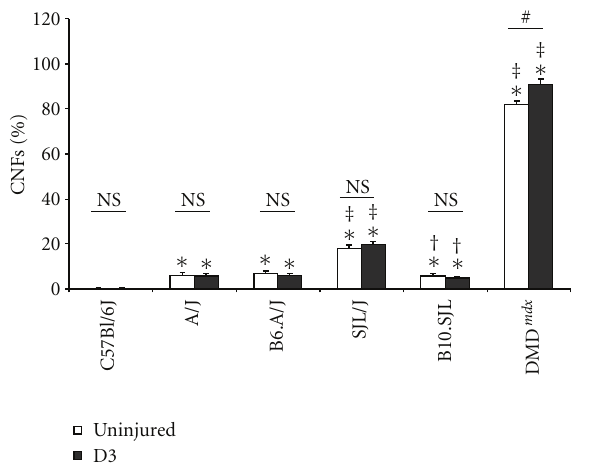
Figure 6: Quantitation of necrotic fibers. We counted necrotic fibers in H&E-stained cross sections of uninjured and injured TA muscles. Necrotic fibers increased significantly at D3 in all mutant strains. A/J muscle showed the largest increase among the dysferlin mutants, but the extent of necrosis in A/J muscles was significantly less than DMD mdx at this time point. ∗ Significant di ff erence compared to control strain at same time point. # Significant di ff er- ence within same strain between uninjured and D3. † Significant di ff erence compared to same Dysf mutation at same time point. ‡ Significant di ff erence compared to A/J at same time